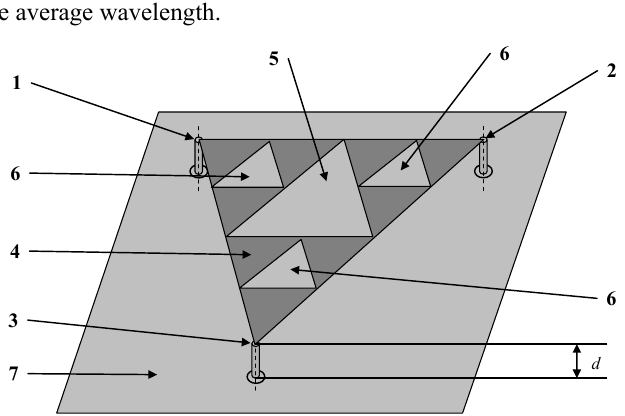
Fig. 1. Multi-band circular polarized antenna (1, 2, 3 - the vertices of a flat emitter of a triangular shape, 4 - a flat emitter of a triangular shape, 5, 6 - resonant holes of a triangular shape, 7 - metal screen) A flat triangular emitter is excited at the vertices by currents of equal amplitude with phases 0, 120, 240 degrees for the first, second, and third vertices,